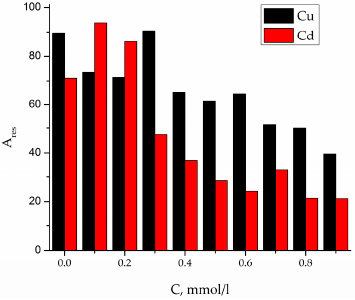
Figure 7. Residual activity of crosslinked urease on the surface of Fe 3 O 4 /SiO 2 -NH 2 -DTPA